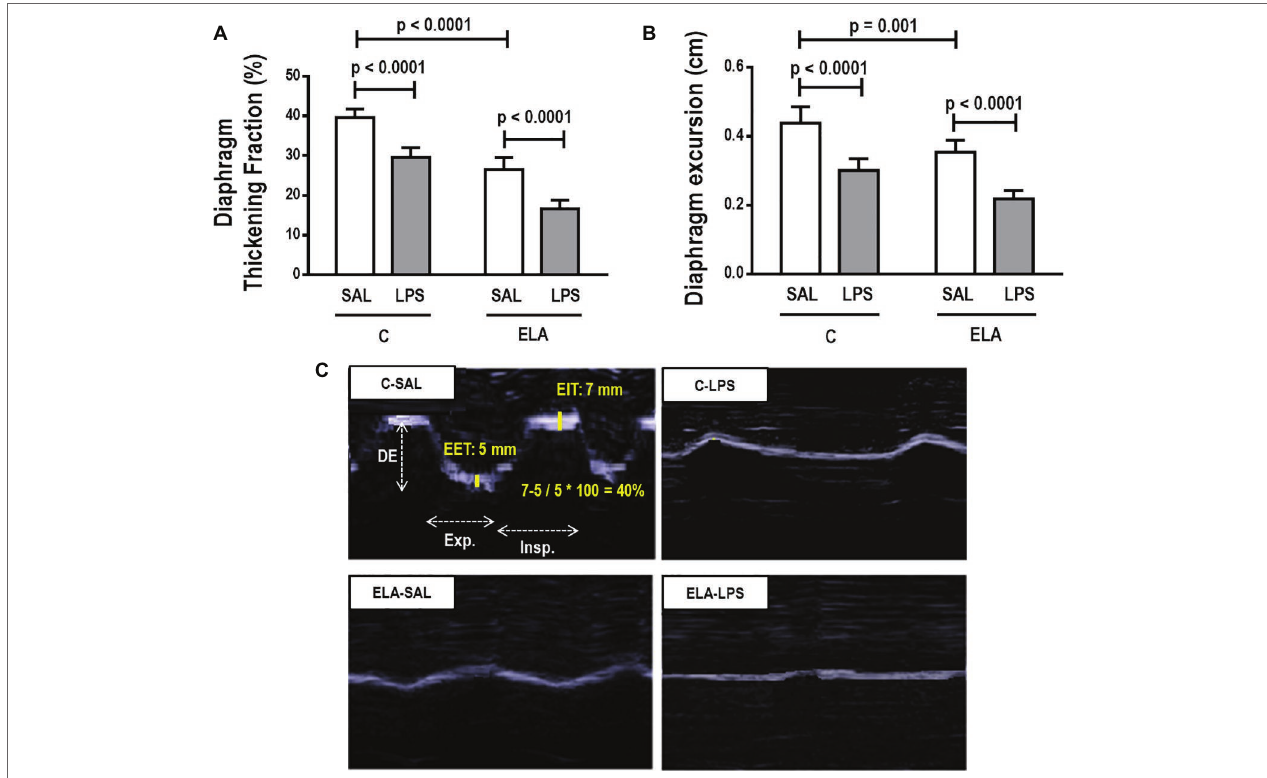
FIGURE 8 | Diaphragm ultrasound. (A) diaphragm thickening fraction, (B) diaphragm excursion, and (C) ultrasonographic view of diaphragmatic excursion (DE) and its thickening fraction (TF), calculated by end inspiratory thickness (EIT) – end-expiratory thickness (EET)/end-expiratory thickness × 100. C, control; ELA, animals treated with intratracheal instillations of elastase; SAL, saline; LPS, E. coli lipopolysaccharide. Values are mean ± SD of six animals in each group.